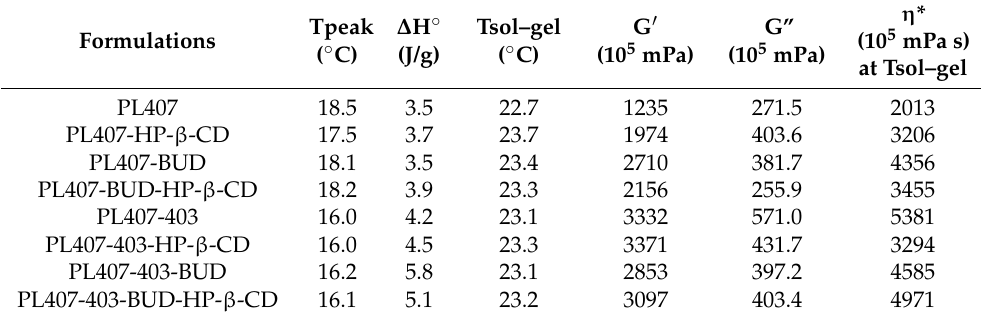
Table 2. Values referring to micellization temperatures (Tm), enthalpy ( ∆ H), G (cid:48) (Elastic), and G (cid:48)(cid:48) (Viscous) moduli, viscosity ( η . mPa s) at 25 ◦ C and 37 ◦ C and sol–gel transition temperatures (Tsol-gel) relative to hydrogels.